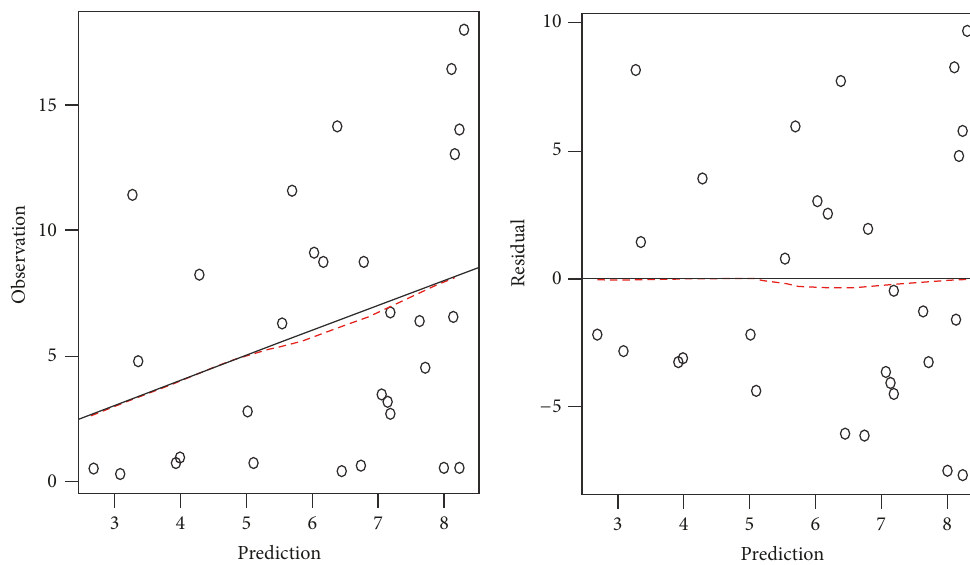
Figure 2: Goodness of fit plots. Both plots indicate that the model adequately fitted the data.